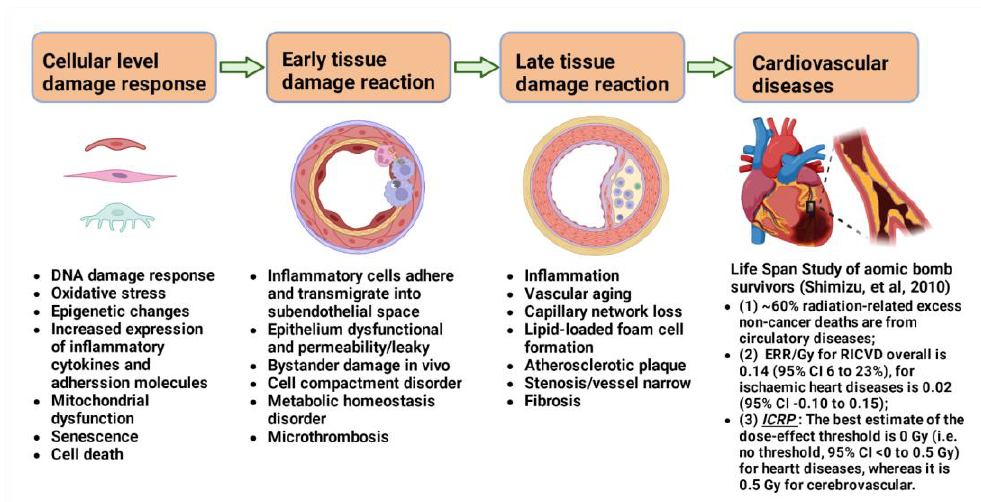
Figure 1. Development of RICVD. Radiotherapy can cause direct and indirect damage of endothelial cells by radiation, acute vasculitis with neutrophil invasion, endothelial dysfunction, altered permeability, tissue reactions, capillary-like network loss, and activation of coagulator mechanisms, fibrosis, and atherosclerosis, ultimately leading to a range of cardiovascular disorders. The main factors at the cellular level are reactive oxygen species (ROS), mitochondrial dysfunction, endothelial dysfunction, and inflammation. Vascular stenosis, atherosclerosis, and fibrosis are examples of late tissue responses in cardiovascular disease.